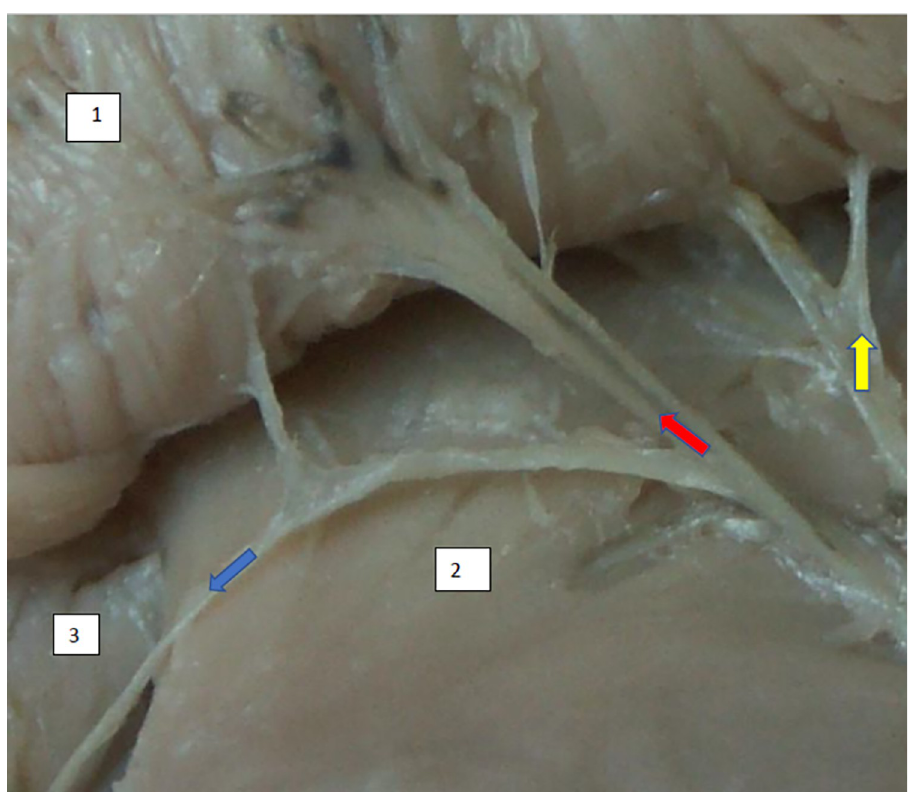
Fig 2. Superior gluteal nerve, tree type, morphological age 162–24–VI, v–tub 190, v–pl 272, mass 512, male sex, magnification 30x, 1–gluteus medius muscle, 2–gluteus minimus muscle, 3–tensor fasciae latae muscle, red arrow–branch to glueus medius muscle, yellow arrow–another branch to gluteus medius muscle, blue arrow– branch to tensor fasciae latae muscle.